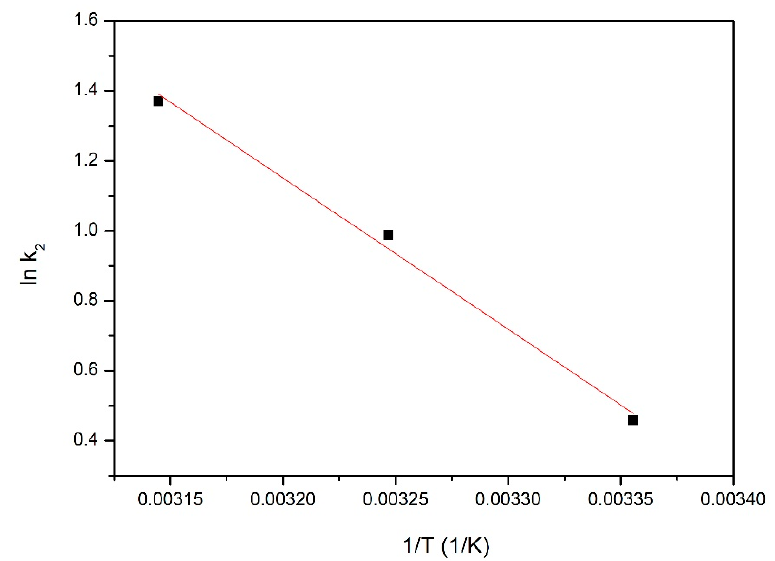
Figure 13. ln k 2 vs. 1/T plot used for adsorption energy calculation.